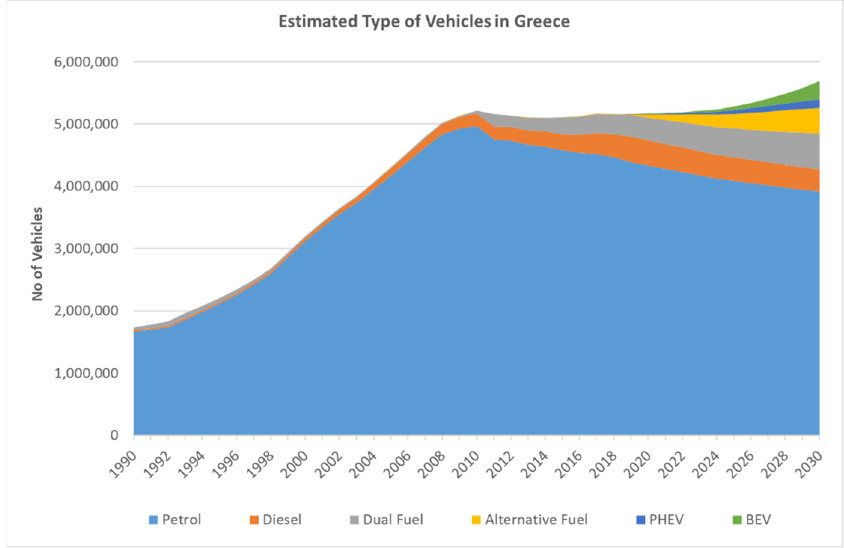
Figure 10. Number of passenger vehicles by fuel type in Greece, 1990–2030.